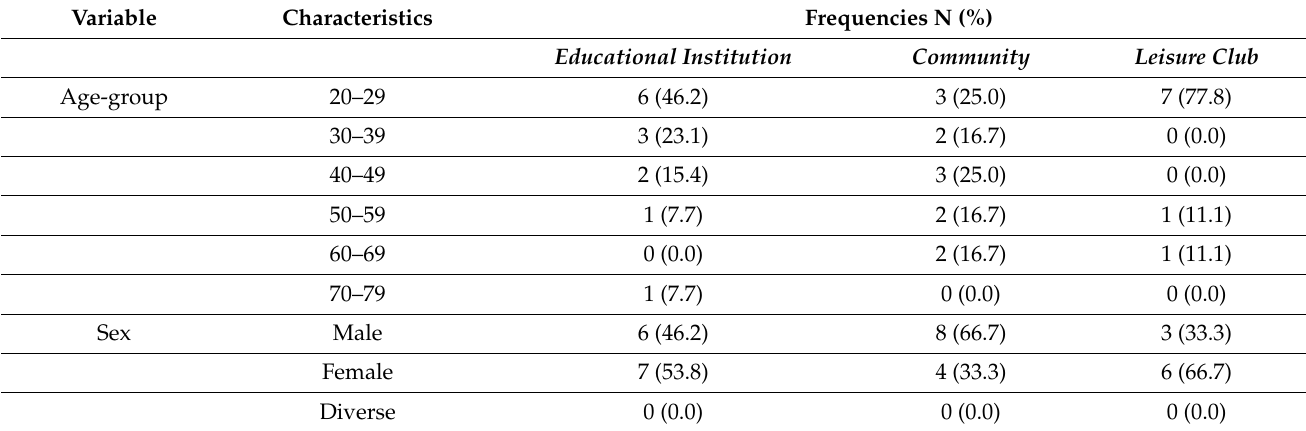
Table 3. Characteristics of the participants in the online World Caf é